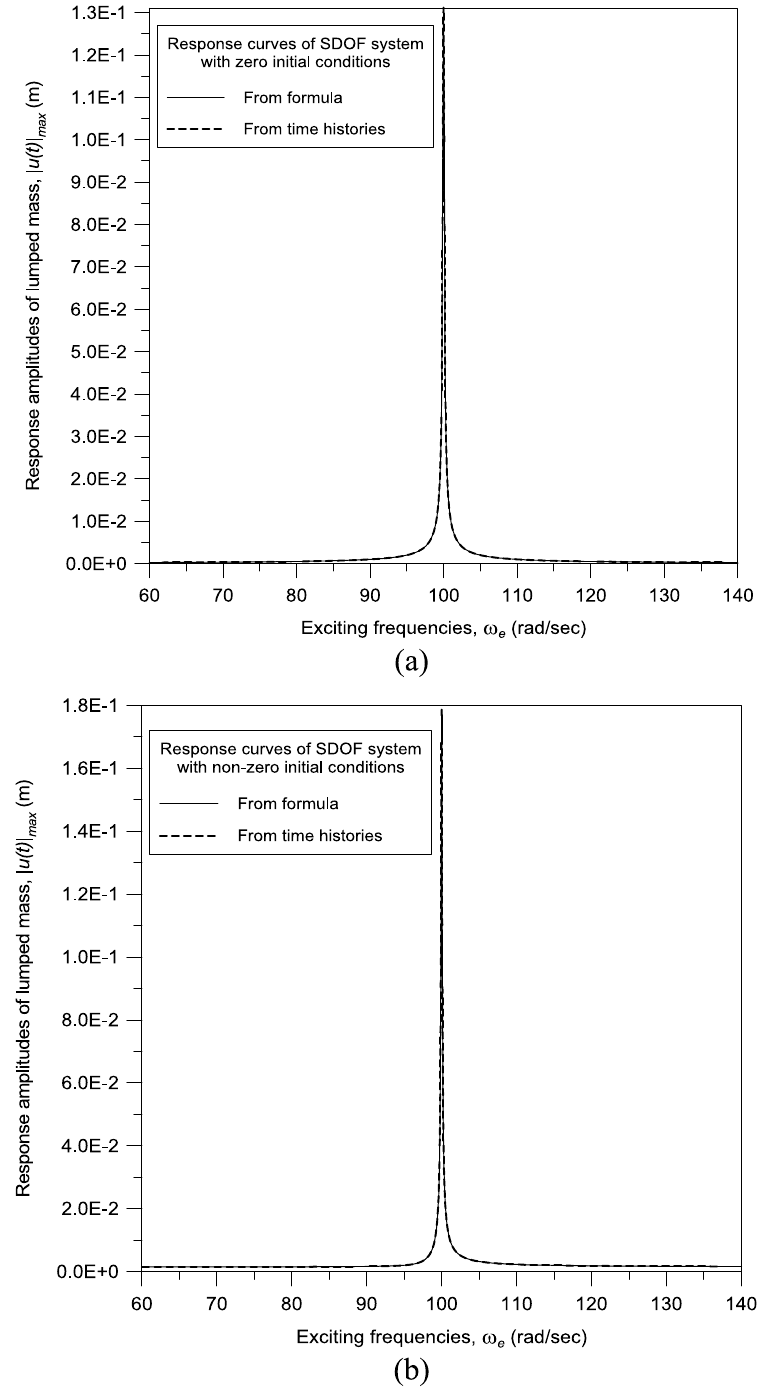
Fig. 3. The frequency-response curves for the total amplitudes obtained from formula ¯ u t = | ¯ u s | + | ¯ u c | (or ¯ u t = | ¯ u s | + ¯ U c ) (denoted by −− ) and conventional time histories ¯ u t = | u ( t ) | max (denoted by − − − ): (a) with “zero” initial conditions (i.e., u 0 = ˙ u 0 = 0); (b) with “non-zero” initial conditions (i.e., u 0 = 0.001 m and ˙ u 0 = 0.1